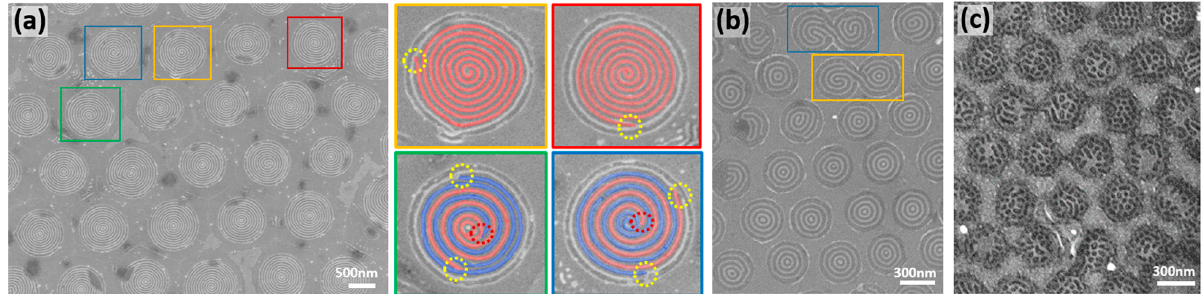
Figure 6. ( a ) SEM images of a dewetted BCP film on a guiding template prepared using 1100 nm colloidal particles. BCP patterns in the colored boxes exhibit spiral morphologies. Right-hand side panels show magnified images of the spiral structures (false-colorized), where the dotted circles indicate Y-junctions (yellow circles = diverging; red circles = converging). ( b ) Dewetted BCP film on a guiding template prepared using 430 nm colloidal particles. Colored boxes indicate merged BCP patterns from two adjacent template areas. ( c ) Dewetted BCP film with a perforated lamellar pattern.